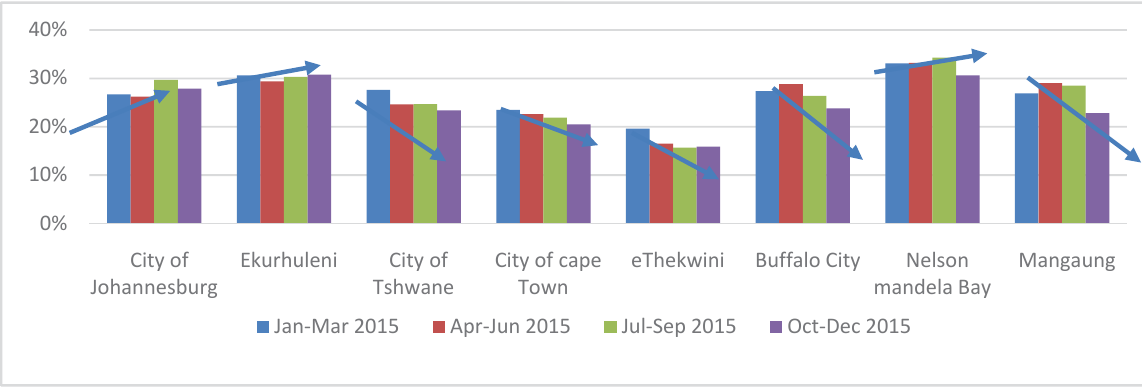
Fig. 7. The unemployment rate by metro 2015 Source: Stats SA Quarterly Labor Force Survey